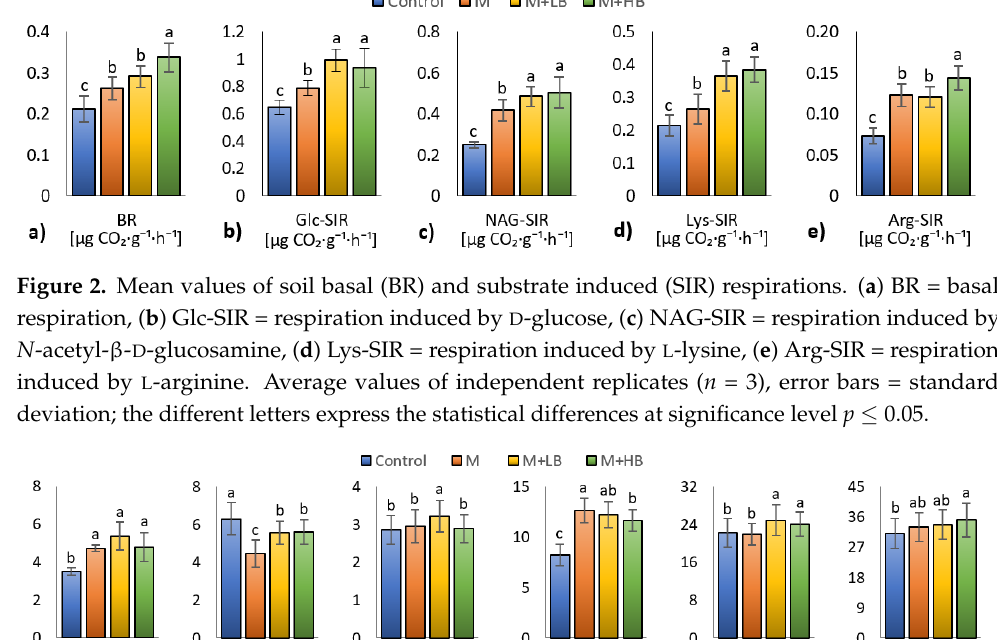
Figure 2. Mean values of soil basal (BR) and substrate induced (SIR) respirations. ( a ) BR = basal respiration, ( b ) Glc-SIR = respiration induced by D -glucose, ( c ) NAG-SIR = respiration induced by N -acetyl- β - D -glucosamine, ( d ) Lys-SIR = respiration induced by L-lysine, ( e ) Arg-SIR = respiration induced by L -arginine. Average values of independent replicates ( n = 3), error bars = standard devi- ation; the different letters express the statistical differences at significance level p ≤ 0.05.